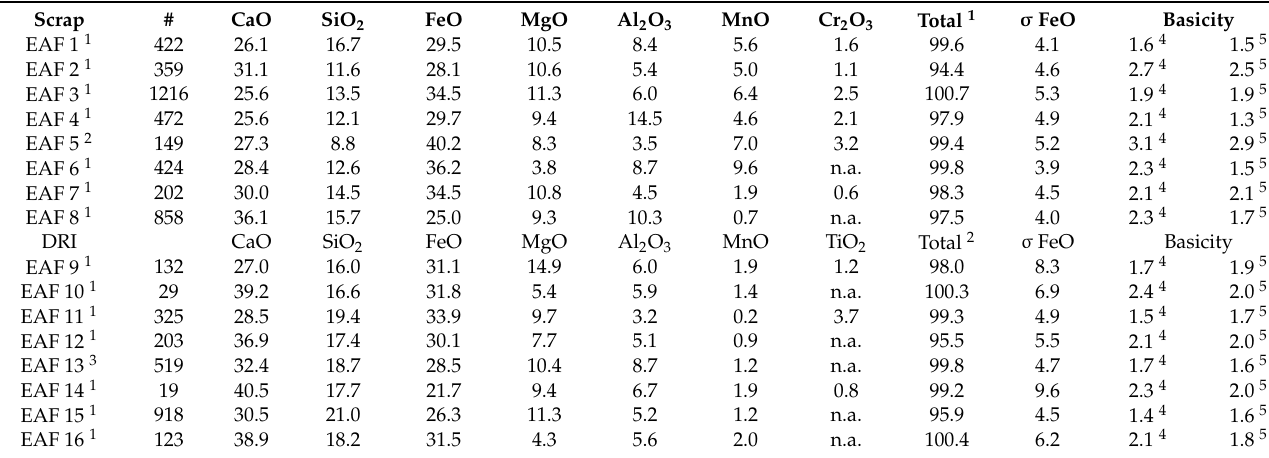
Table 3. Average slag compositions at the tapping of EAFs charged with steel scrap only and charged with scrap and >50% DRI (slag compositions in wt